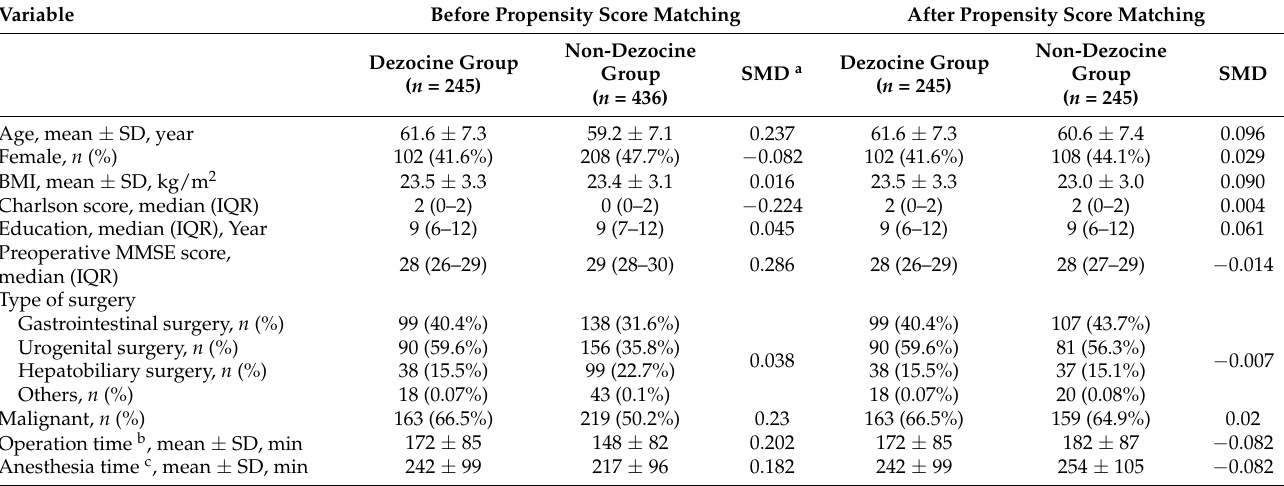
Table 3. Comparisons between cohort preoperative characteristics before and after propensity score matching.